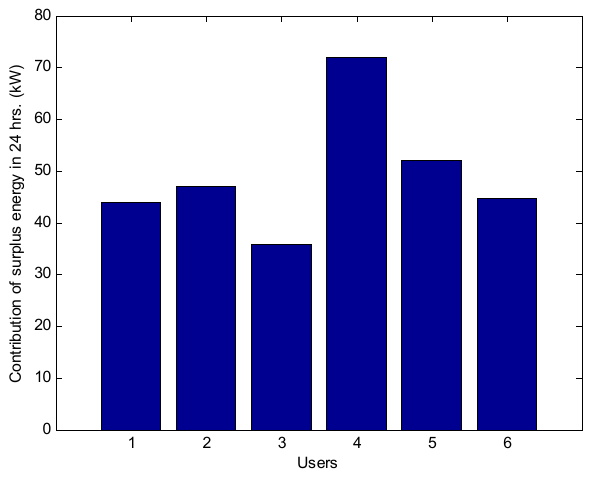
Figure 8. Contribution of surplus energy.